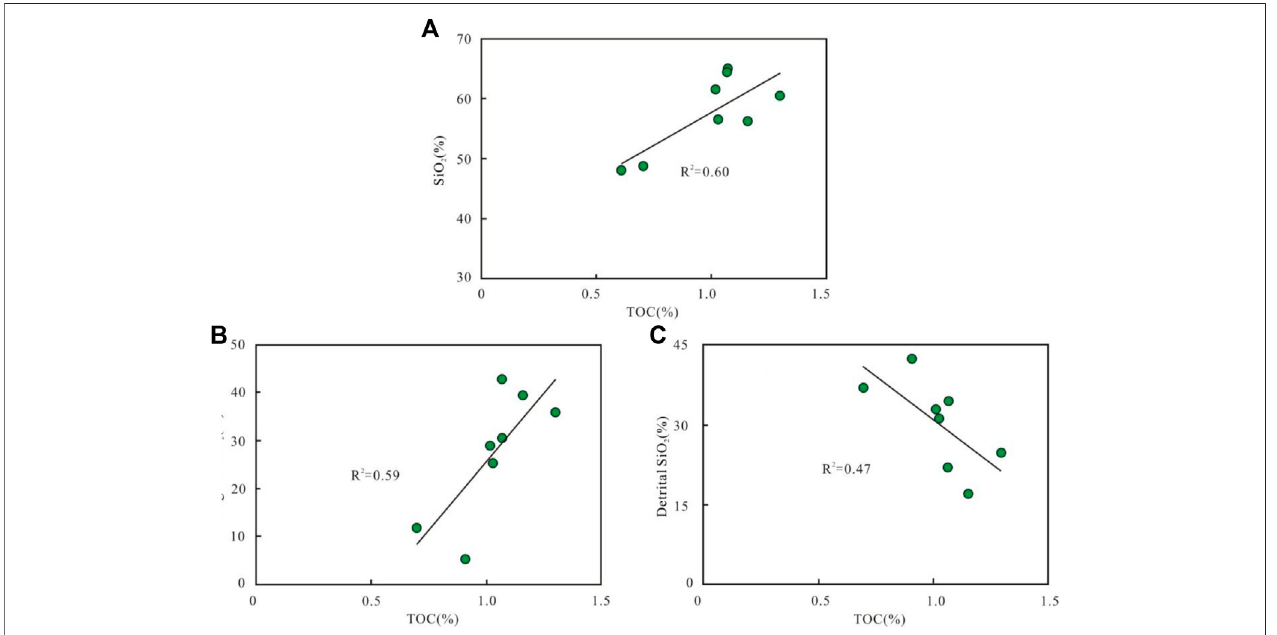
FIGURE 11 | Correlation diagrams of SiO 2 and TOC contents. (A) The positive correlation between SiO 2 and TOC. (B) The positive correlation between biogenic SiO 2 and TOC. (C) The negative correlation between detrital SiO 2 and